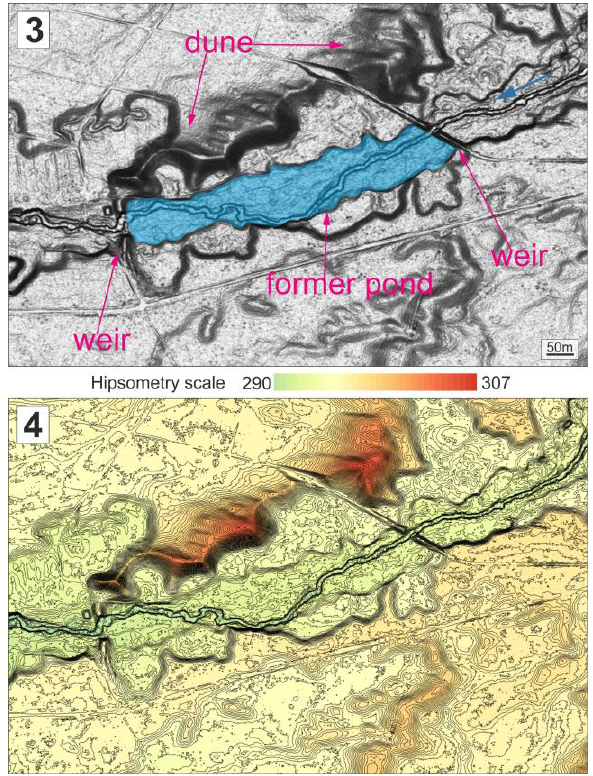
Fig. 4. Location of the Regolowiec former ironworks: 3 – on the shaded relief map; 4 – on the coloured contour